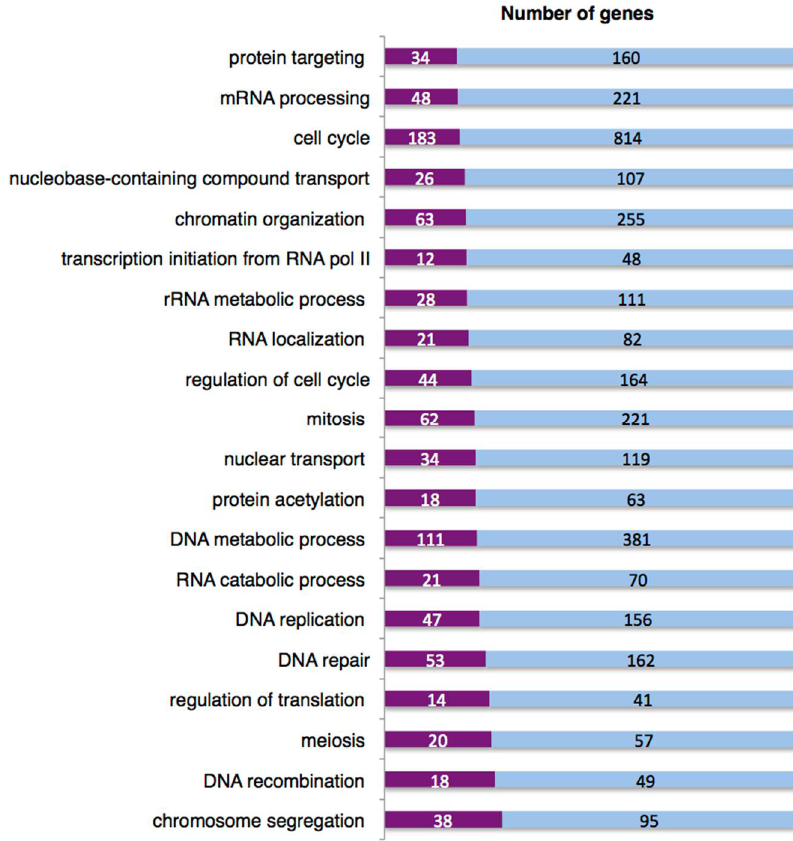
Figure 7. The DNA damage response induced by Melphalan affects splicing of cellular genes with various biological functions, including genes encoding mRNA processing factors. The data set obtained with the Affymetrix GeneChip Human Transcriptome array 2.0 and described in the legend of Figure 6 was analysed with the Transcriptome Analysis Console software (TAC) from Thermo Fisher. Protein coding genes with at least one two-fold change in the use of a splice junction or exon inclusion were exported into PANTHER, version 13.1, Gene List Analysis tool (Available online: http://pantherdb.org) for an overrepresentation test based on their biological function. Results of the RNA array analysis of DMSO or melphalan treated C33A2 cells are displayed as percentage of genes in each category that displayed altered splicing upon melphalan treatment. The blue area represents total number of genes in each biological category, and the purple area represents the number of genes producing mRNAs with altered alternative splicing in response to melphalan.